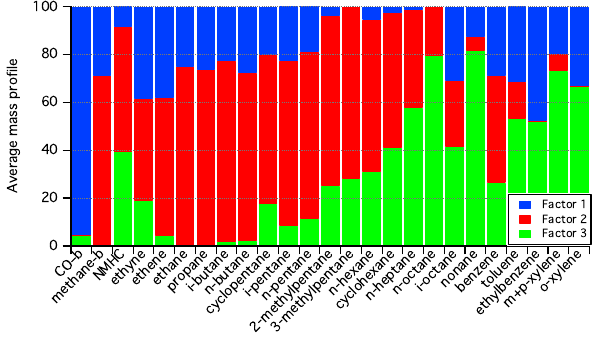
Figure 5. Percentage contribution of PMF factors to the average mixing ratio of each analyzed pollutant ( − b signifies minus back- ground) from the whole sampling period at Boulder South Road